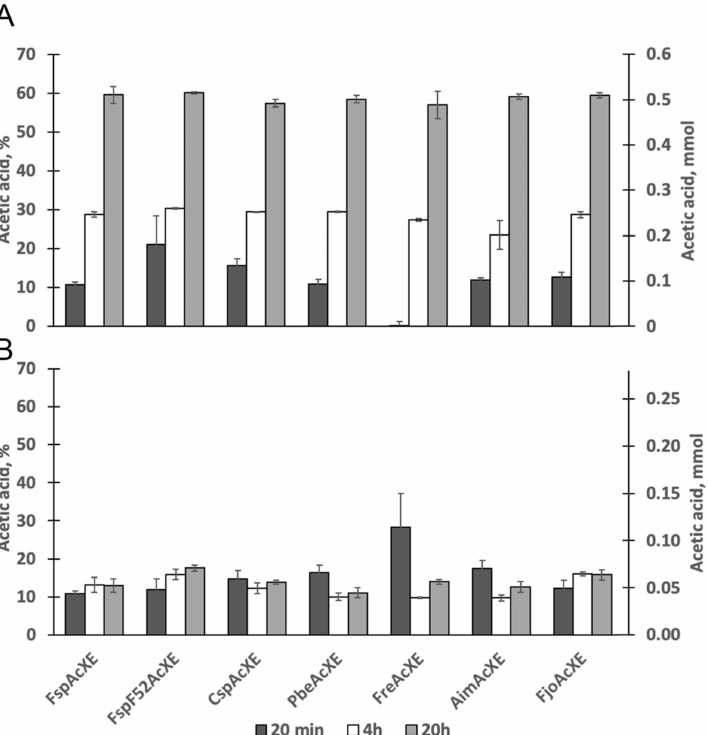
Figure 2. Acetic acid release from ( A ) per-acetylated xylooligosaccharide (DP 4–7) using 2 µ g of enzyme, and ( B ) from CF-XOS using 1 µ g enzyme. Reactions (60 µ L in Subfigure ( A ) and 50 µ L in Subfigure ( B )) were performed at 50 mM HEPES and pH 7.0, and were incubated for 20 min, 4 h, and 20 h. Acetic acid release was detected with acetic acid kit (K-ACETRM, Megazyme). Error bars represent standard deviation ( n =